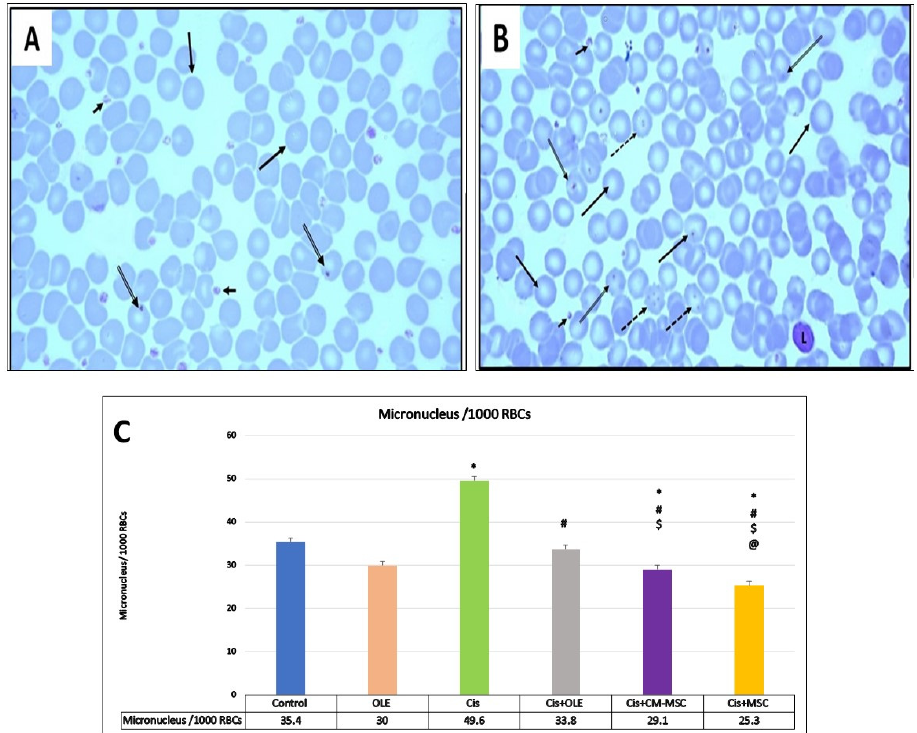
Figure 2. Photomicrographs of blood smear of control group ( A ) and Cis group ( B ) stained with Giemsa. Many RBCs showed normal morphology (long arrow), some were micronucleus-including (double arrow) and some echinocytes with multiple inclusion bodies (dashed arrow) were evident in the Cis group. Platelet (short arrow) and lymphocytes (L) were seen among RBCs. ( C ): A bar chart showing micronucleus frequency in 1000 cells/each group in the study. Mean ± SD was used to express the data of the experiment. Significant in comparison to control group (*), Cis group (#), Cis + OLE group ($) and Cis + CM-MSC group (@); ( p < 0.05).